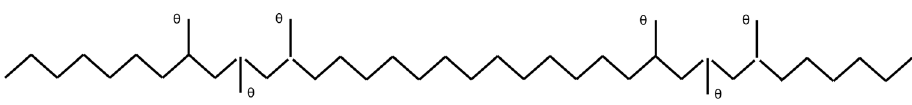
Figure 1. The molecular structure characteristics of polyacrylamide polymer.